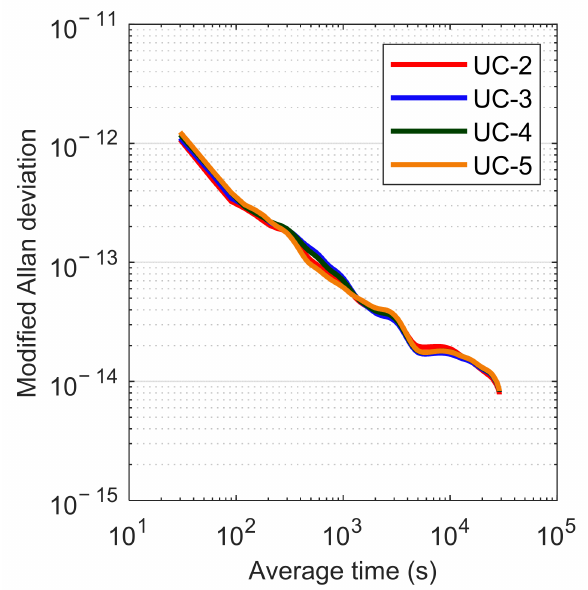
Figure 16. MDEV of the time link BRUX-KOKB derived from Galileo dual-, triple-, four-, and five-frequency UC PPP on DOY 248, 2021.